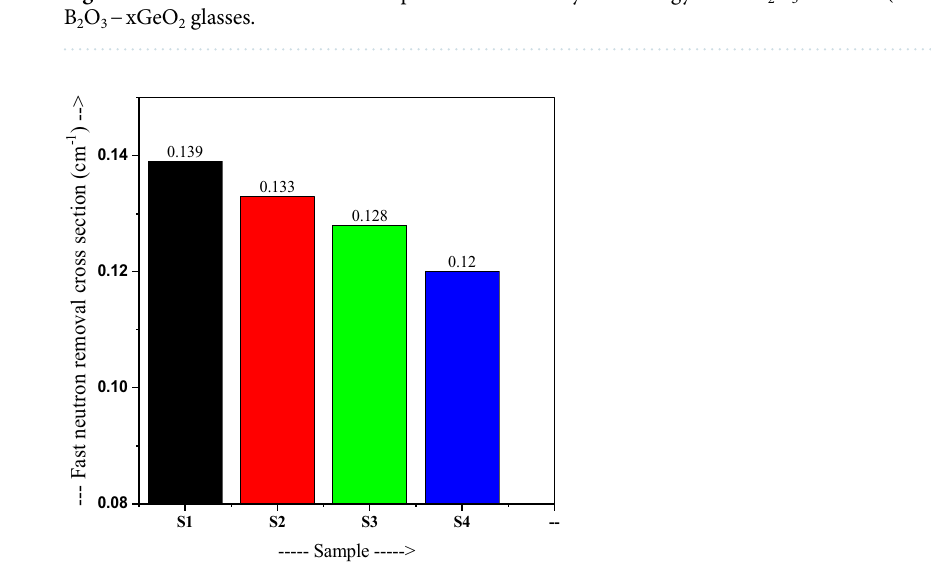
Figure 19. The fast neutron removal cross-section for 20Bi 2 O 3 − xPbO − (80 − 2x)B 2 O 3 − xGeO 2